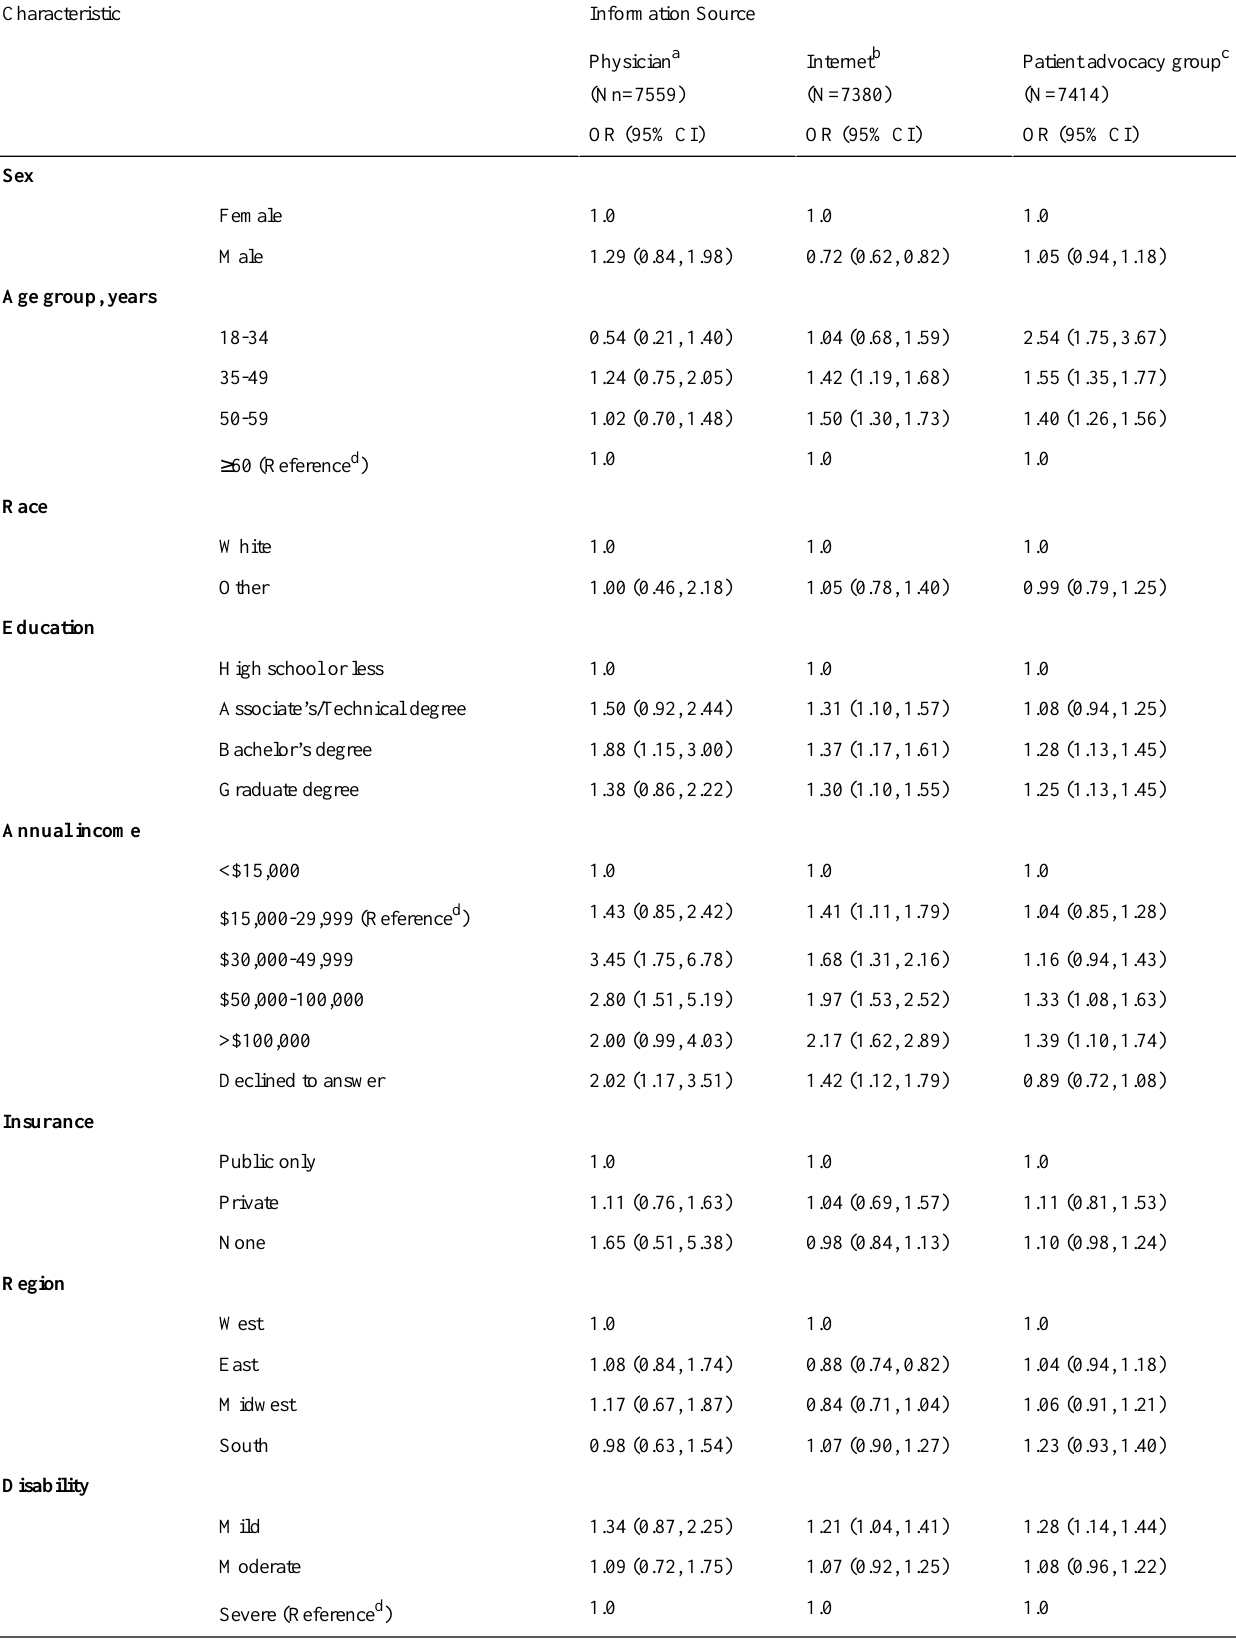
Table 5. Demographic and clinical characteristics associated with trust (“some” or “a lot”) versus lack of trust in sources of health information. Information